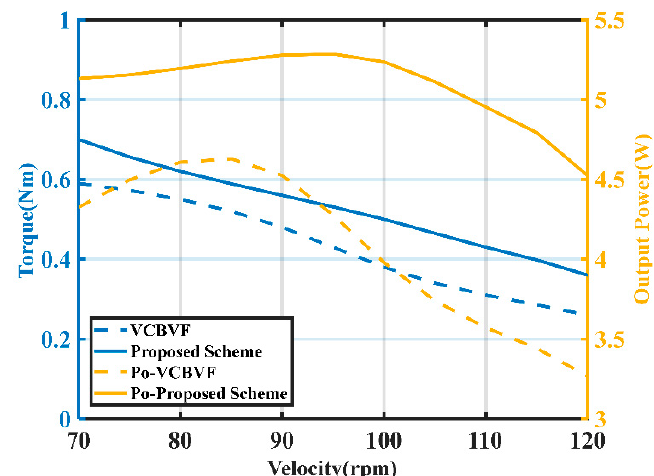
Figure 13. Comparison of the torque-velocity characteristics with different control schemes.